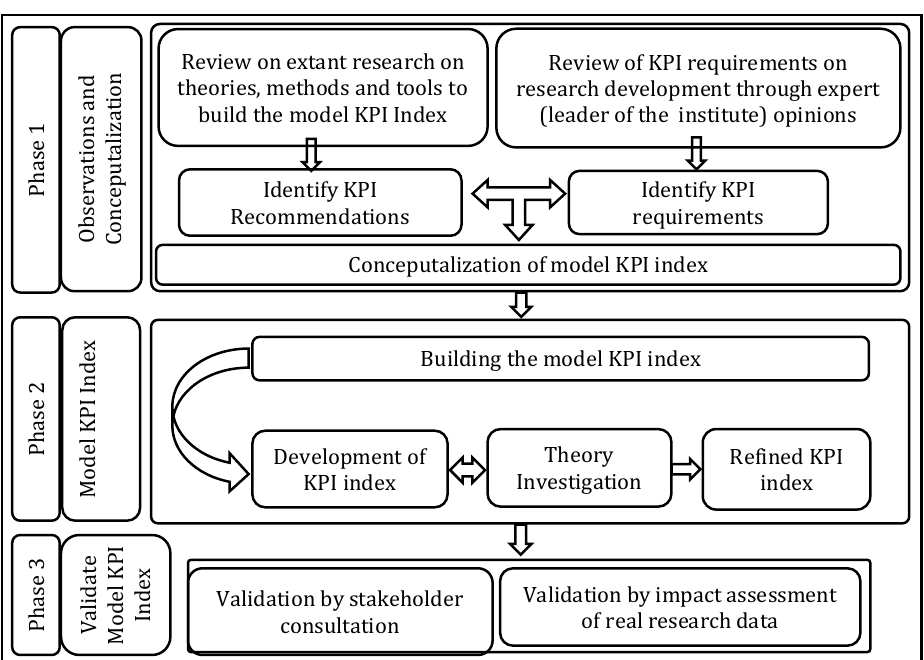
Figure 1: A Framework for Converting Individual KPIs into KPI Index to Measure Research